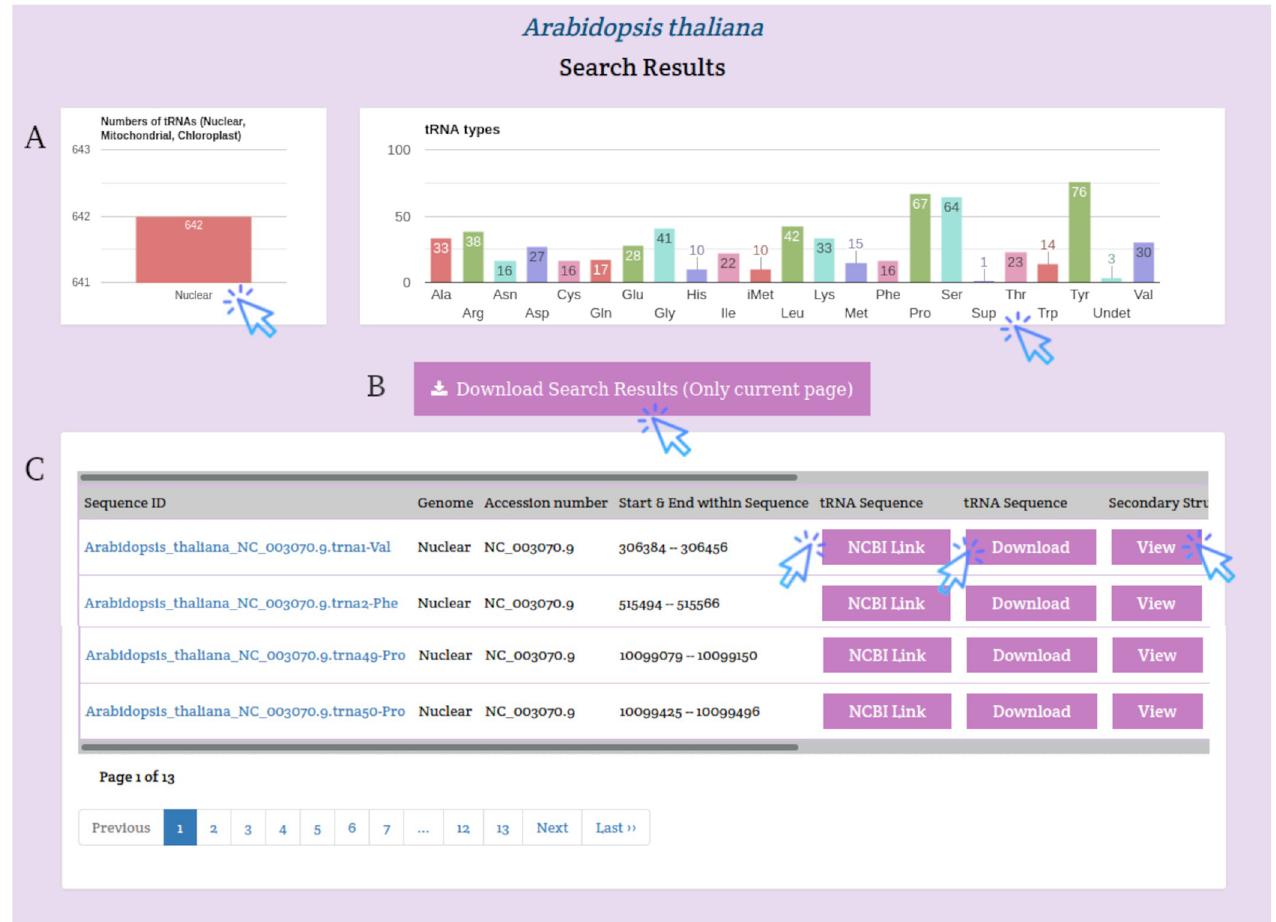
Fig 4. Arabidopsis thaliana search results. A) Visualize statistics subsection, B) button to download results, C) summary of search results with a hyperlink button for three separate pages to retrieve tRNA FASTA sequence from NCBI, download tRNA FASTA sequence from PltRNAdb, and retrieve details of the selected